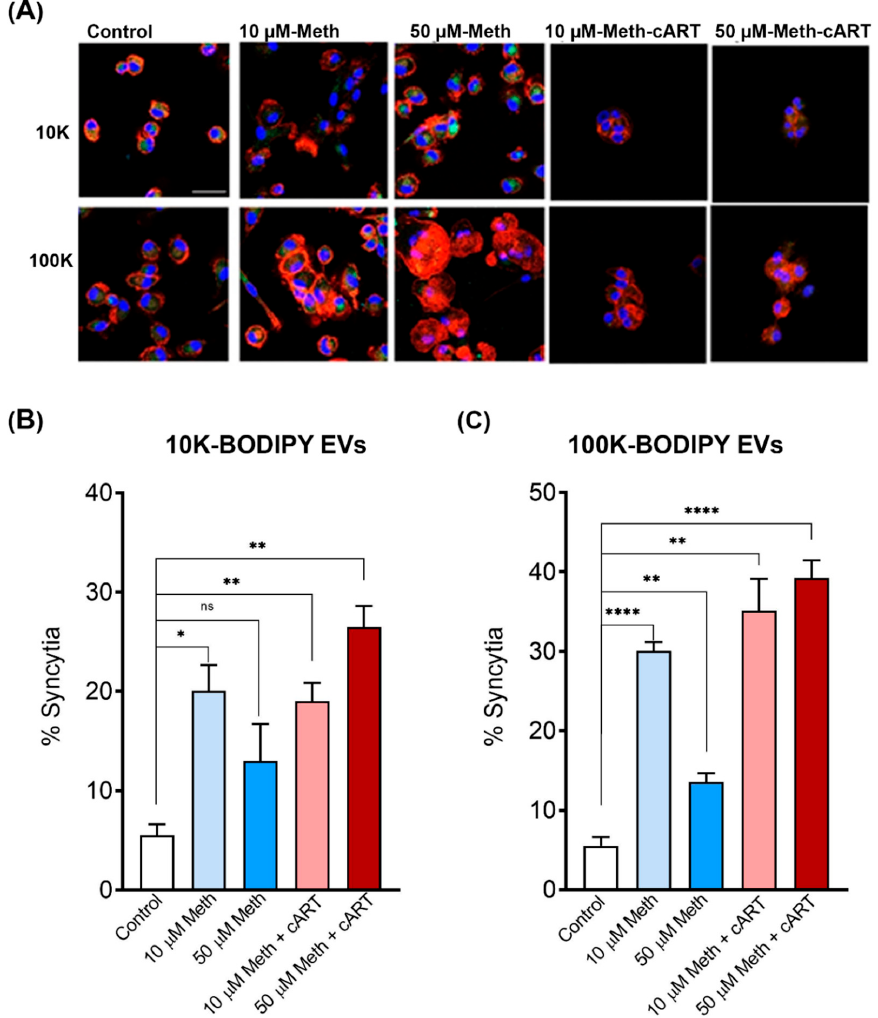
Figure 4. Syncytia count induced by various groups of 10 K and 100 K EV at 3 h ( A ). MDMs from 10 K ( B ) and 100 K ( C ) EV set of different U1 groups for 3 h. Data are shown as mean +/ − SEM and represent at least three independent assays done in triplicate. * p < 0.05; ** p < 0.01; **** p < 0.0001, and ns = not significant.